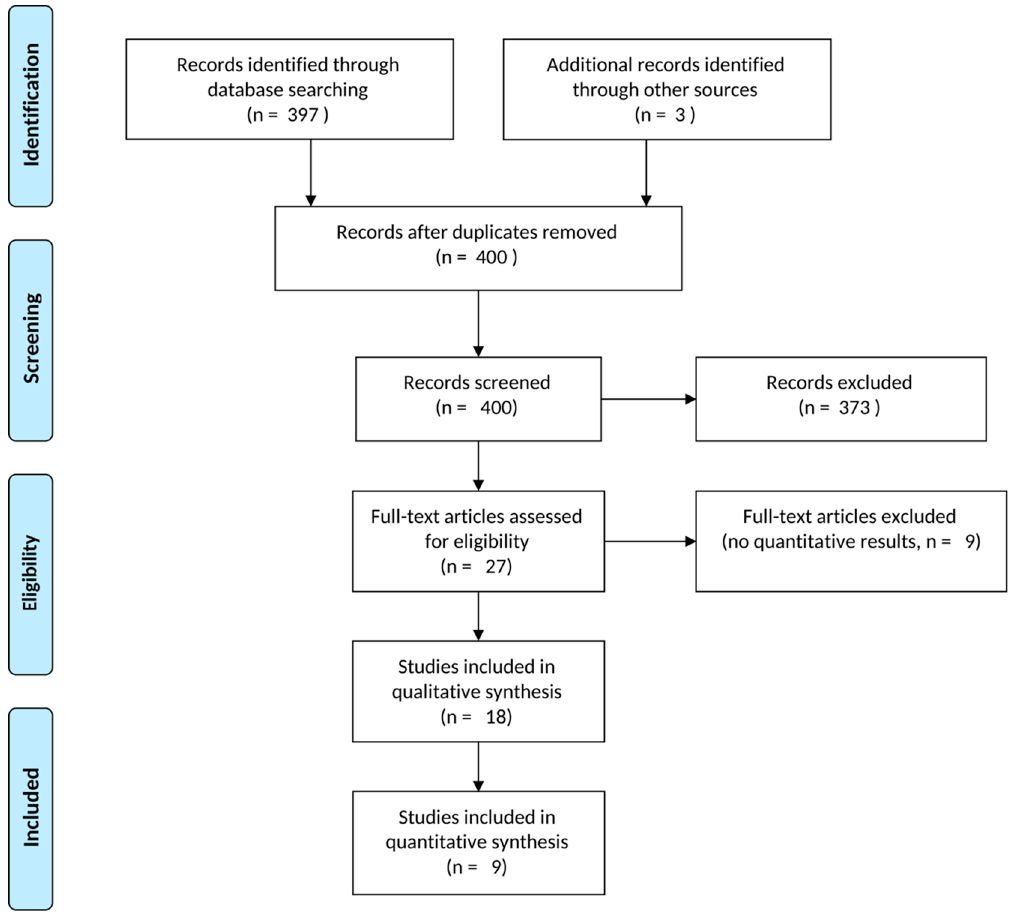
Figure 2. Flow Diagram of the study according to PRISMA methodology.